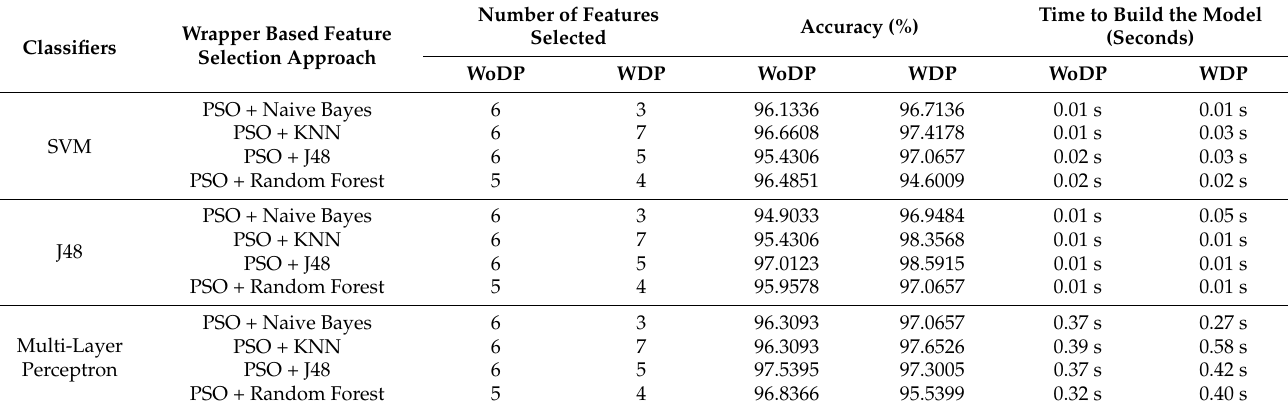
Table 5. Accuracy comparison of classifiers on data with greedy stepwise feature